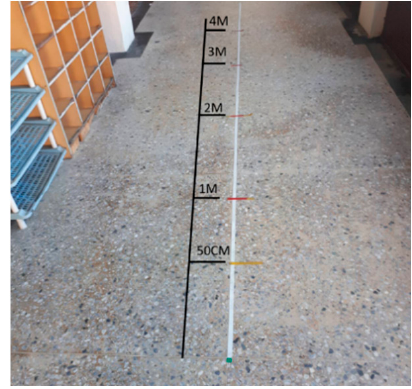
Figure 12. The test site for walking straight.